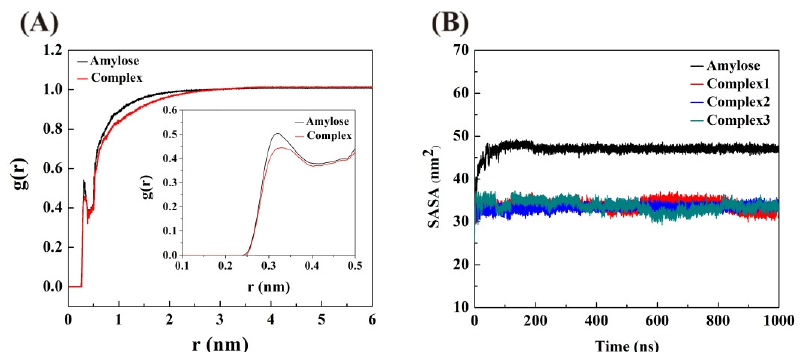
Figure 7. ( A ) Radial distribution functions (RDF) of amylose molecule in single-strand system (black lines) and the average RDF of amylose molecule in three different amylose–zein complexes with different initial values (red lines); ( B ) Solvent accessible surface area (SASA) of amylose molecule in both the single-strand system (black line) and three amylose–zein complexes with different initial values (red, blue and green lines).